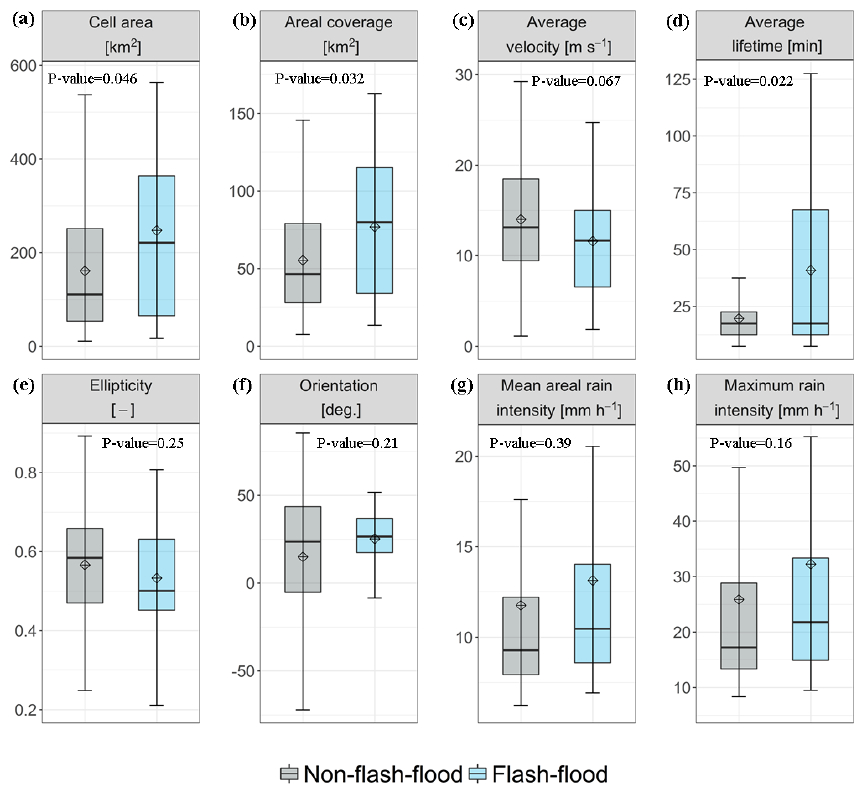
Figure 10. Comparison of dominant flash-flood-related cells (blue, N = 29) and non-flash-flood-related cell (grey, N = 144) properties: (a) cell area (km 2 ), (b) areal coverage (km 2 ), (c) average velocity (ms − 1 ), (d) average lifetime (min), (e) ellipticity, (f) orientation ( ◦ ), (g) mean areal rain intensity (mmh − 1 ), and (h) maximum rain intensity (mmh − 1 ). Values are averaged over the dominant cell’s lifetime. Boxplot properties are as specified in Fig. 5. Reported P values are of the ANOVA test applied between dominant flash-flood-related cells and non-flash-flood-related cells. All data sets were tested first for variance heterogeneity using Levene’s test (with squared deviations).The Box-Cox transformation technique was applied to properties of unequal variances to obtain normality. In these cases, Welch’s test was